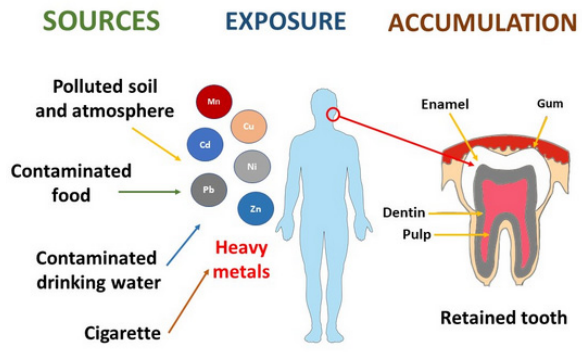
Figure 2. The sources of toxic metals.